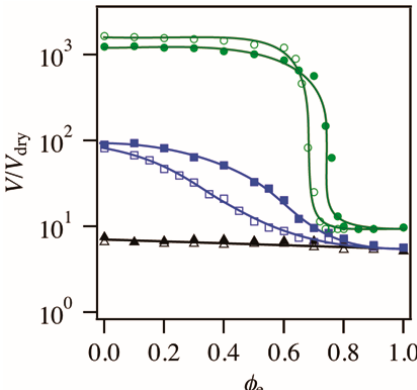
Figure 4. The degree of swelling V / V dry of sulfonated SR gels in the lower ionization region as a function of ethanol volume fraction, φ e , in the ethanol-water mixture. The average numbers of sulfo groups per CD were 0 (triangle), 0.67 (square), and 1.5 (circle). Filled and open symbols denote the shrinking and swelling processes, respectively. Solid lines are eye guides.